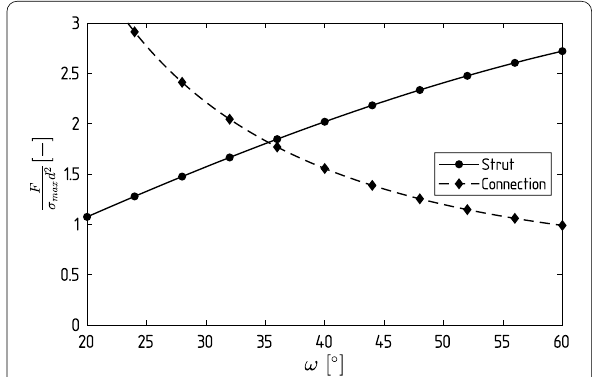
Figure 11 Failure in struts and connection as a function of relative angle